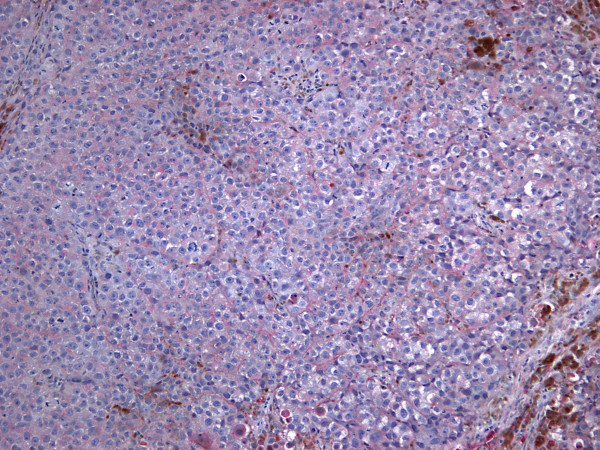
Immunohistochemical staining for bFGF in group V (HILP): Angioneogenesis is less pronounced as in group I. Brown clusters represent melanin.